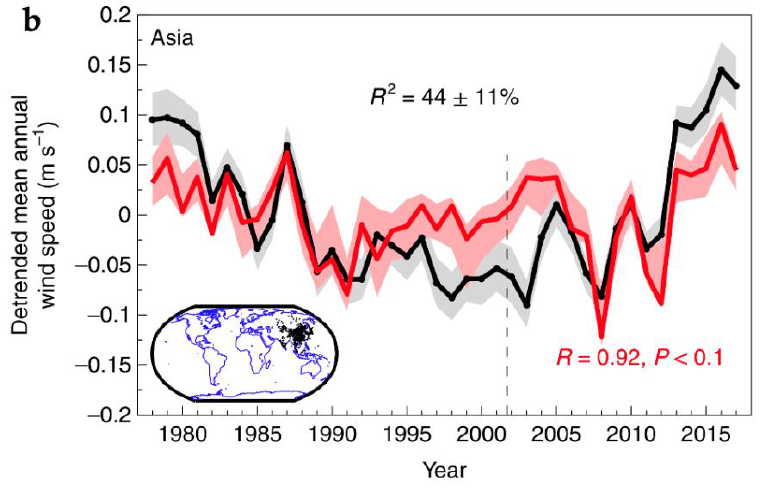
Figure 4. ( a ) Detrended mean annual global wind speed [5]. ( b ) Detrended mean annual wind speed in the Asian region [5].